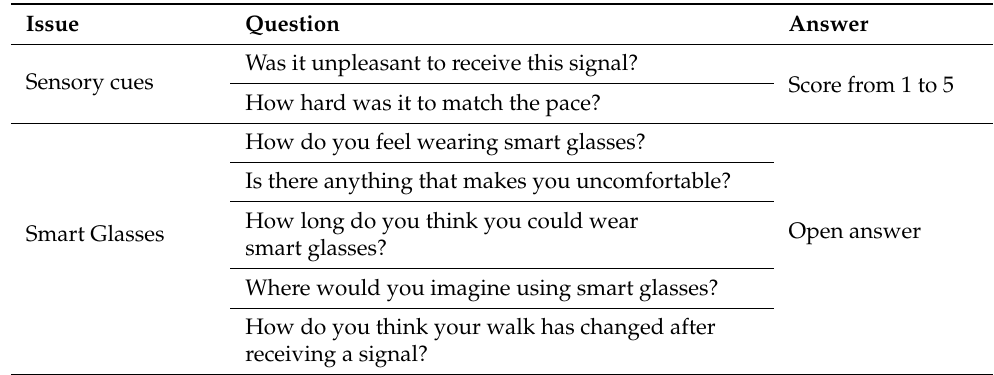
Table 1. Users individual